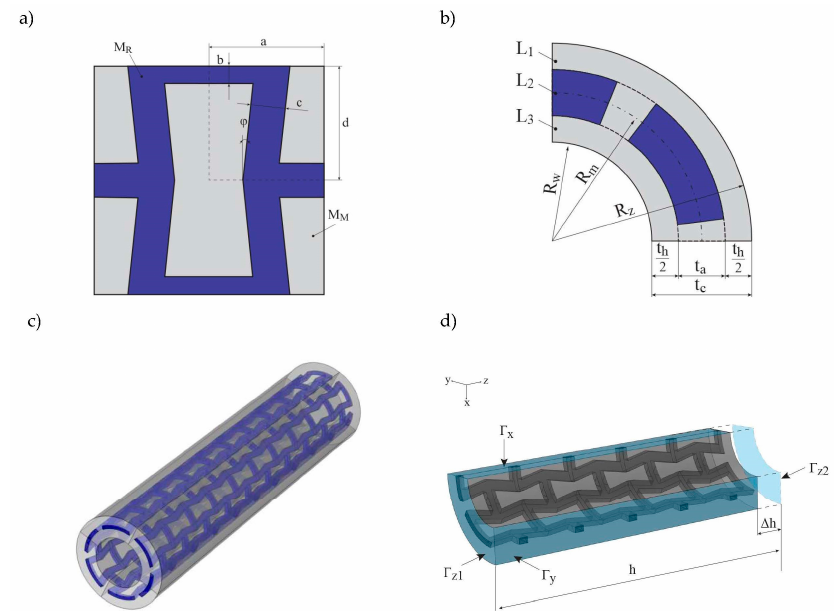
Figure 1. The geometry of composite tube: ( a ) composite unit cell of reinforcement layer, ( b ) quarter of cross-section with all of the layers marked ( c ) three-dimensional view of the whole tube, ( d ) the considered one-eighth of the tube with boundary conditions marked.